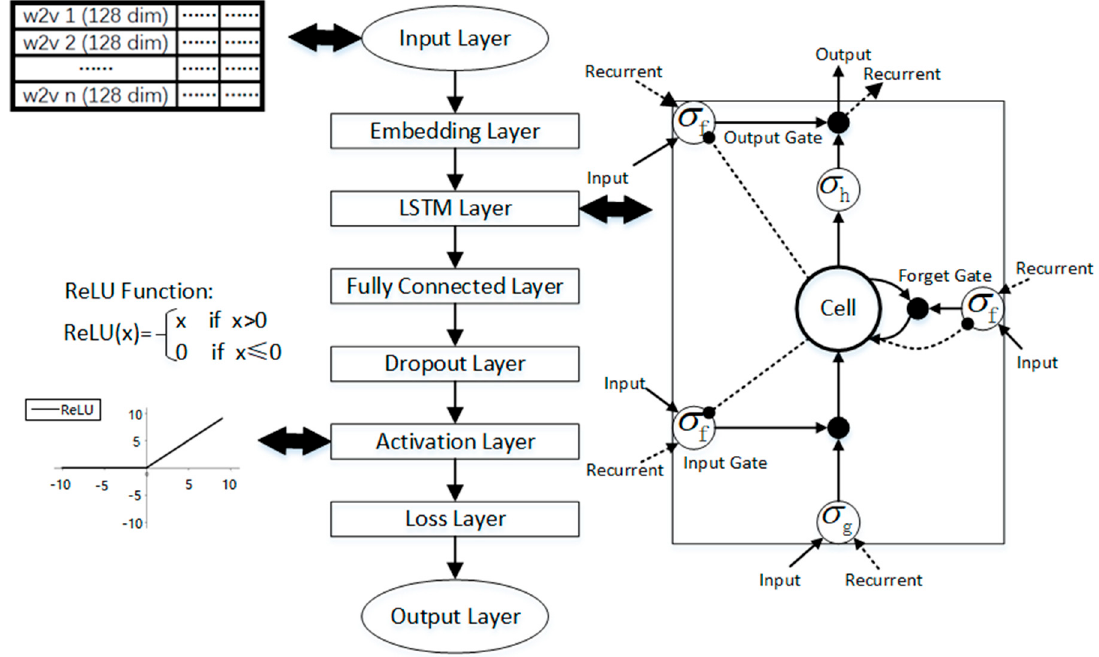
Figure 8. Structure of the Long Short Term Memory Networks Constructed by Layers.